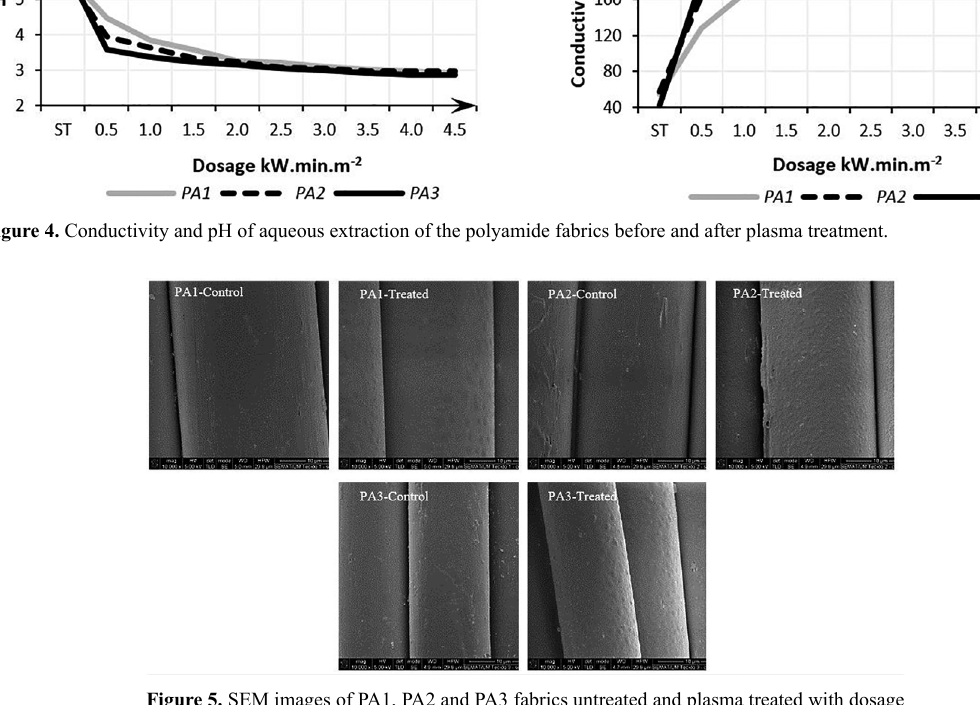
Figure 5. SEM images of PA1, PA2 and PA3 fabrics untreated and plasma treated with dosage of 2.5 kW.min.m -2 with magnification of 10000